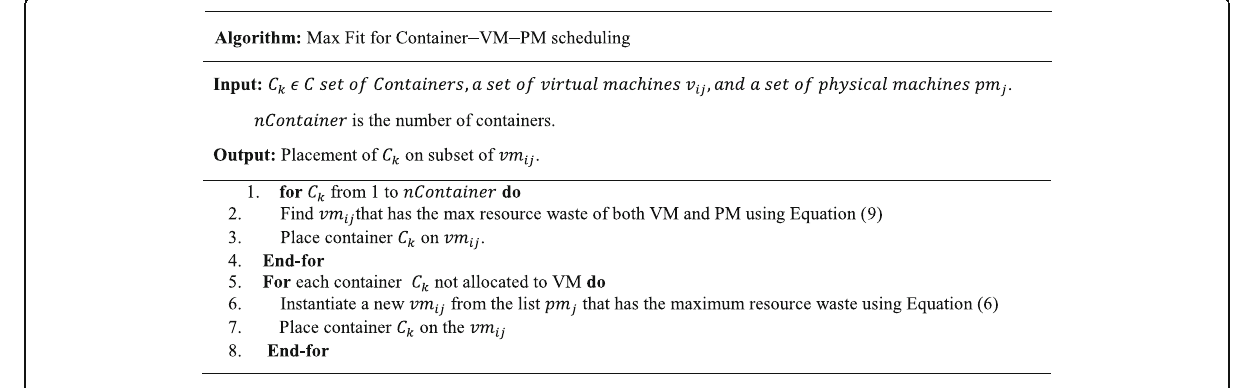
Fig. 6 The Max Fit algorithm for container-VM-PM